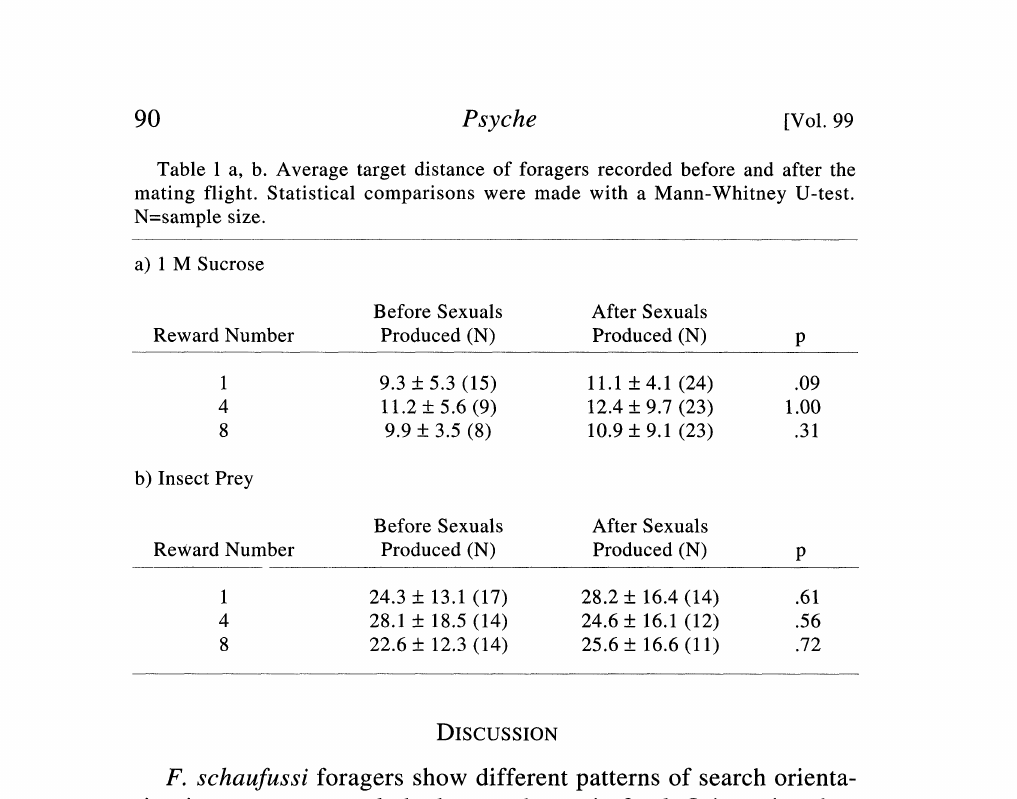
Table a, b. Average target distance of foragers recorded before and after the mating flight. Statistical comparisons were made with a Mann-Whitney U-test. N=sample